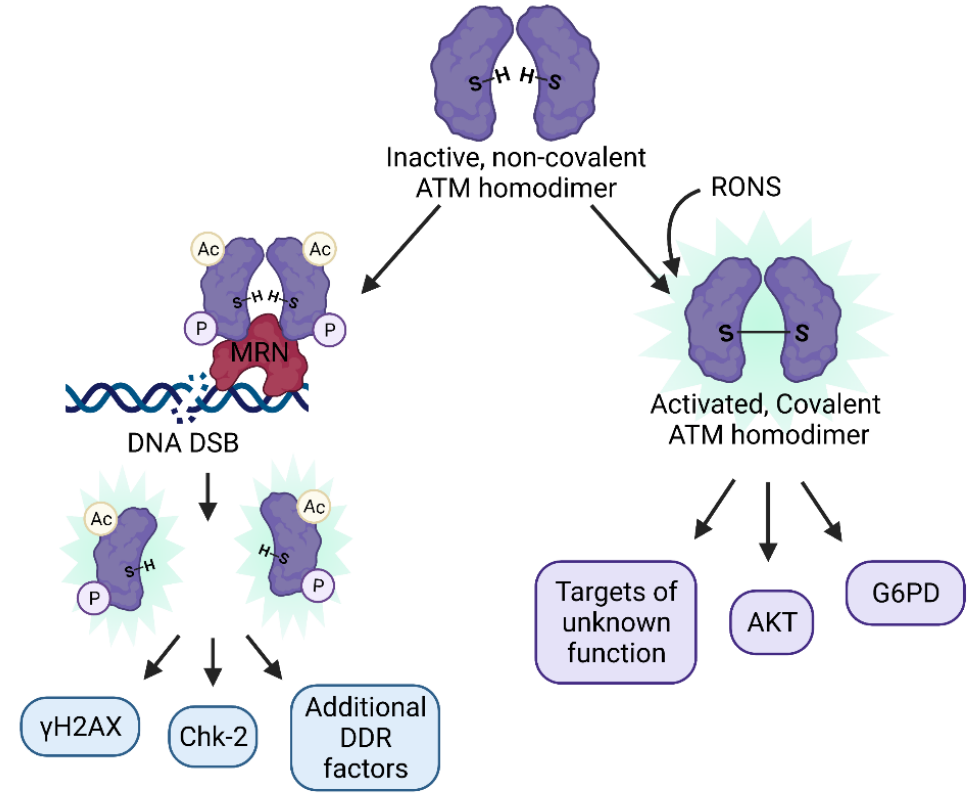
Figure 2. The two distinct mechanisms of ATM activation: ATM usually exists in an inactive, non- covalent homodimer form that can become activated via (left) the canonical DDR upon recruitment to the MRN complex near the site of DSBs, trans autophosphorylation and acetylation, monomerization, and targeting of downstream DDR effectors such as H2AX, Chk-2, KAP-1, p53, and others, or (right) through oxidation by RONS of cysteine residues that result in a covalently attached ATM homodimer, which targets AKT, G6PD, and hundreds of additional downstream substrates, many of which are of unknown function.